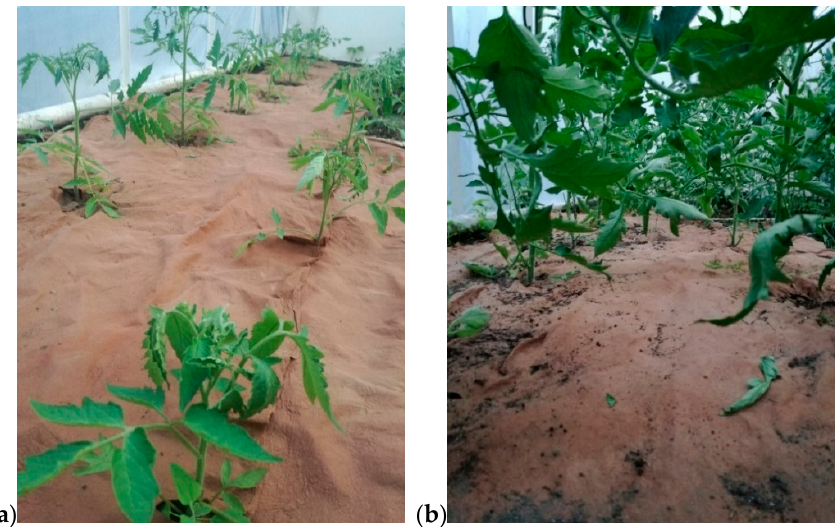
Figure 3. Mulching the tomatoes with nonwoven C: ( a ) at the beginning of the research, ( b ) after 2 months of the research.